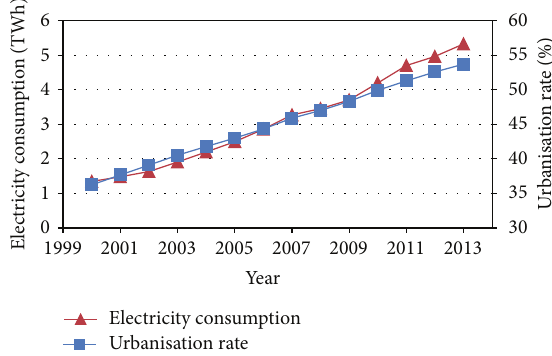
Figure 2: Electricity consumption and urbanisation rate of China from 2000 to 2013